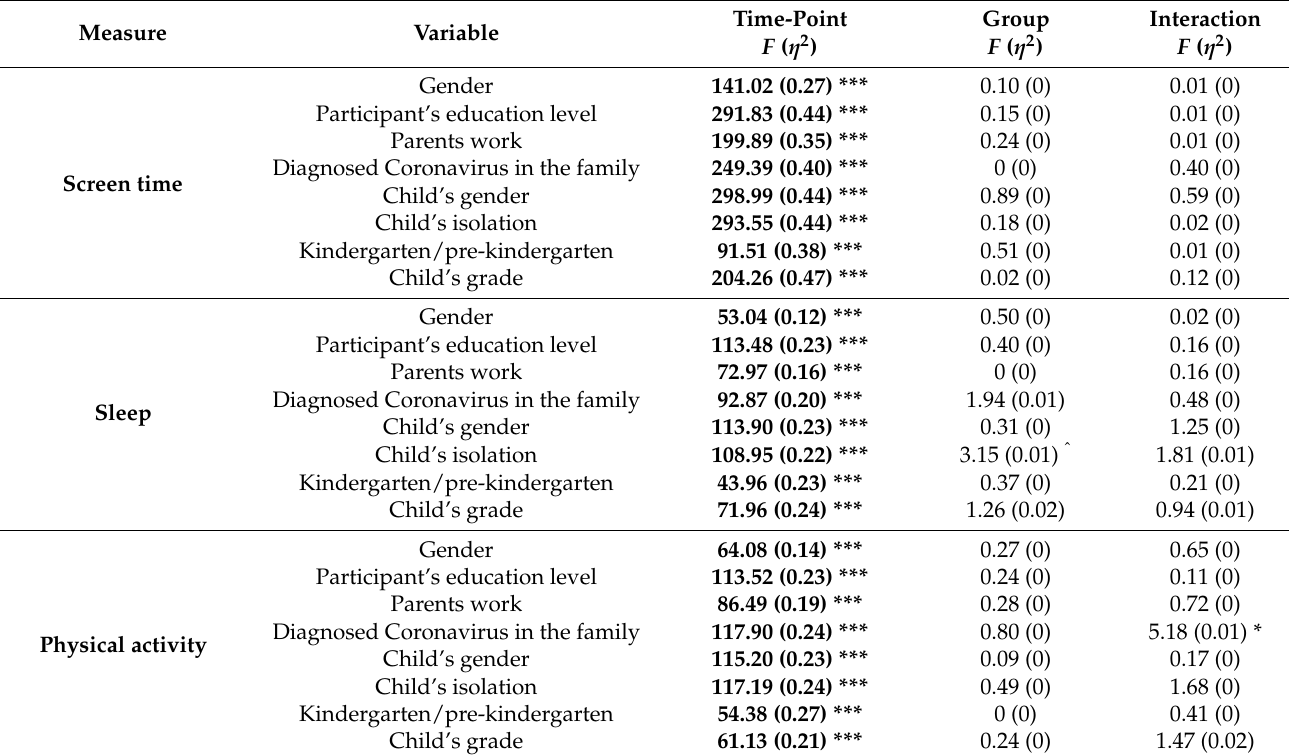
Table 7. ANOVA results comparing the time spent in use of screens (number hours a day), sleep and physical activity pre and during the COVID-19